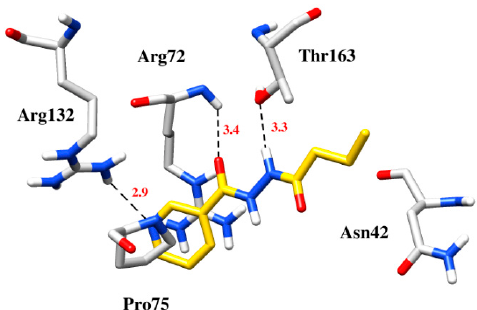
Figure 11. Binding pose of 4 with the antibacterial target protein (light grey) topoisomerase IV. The dashed black line depicts hydrogen bond interaction. Table 3. Docking scores and binding interaction of pyridine-containing lipophilic hydrazides with the active site residues of antibacterial and antifungal target proteins.